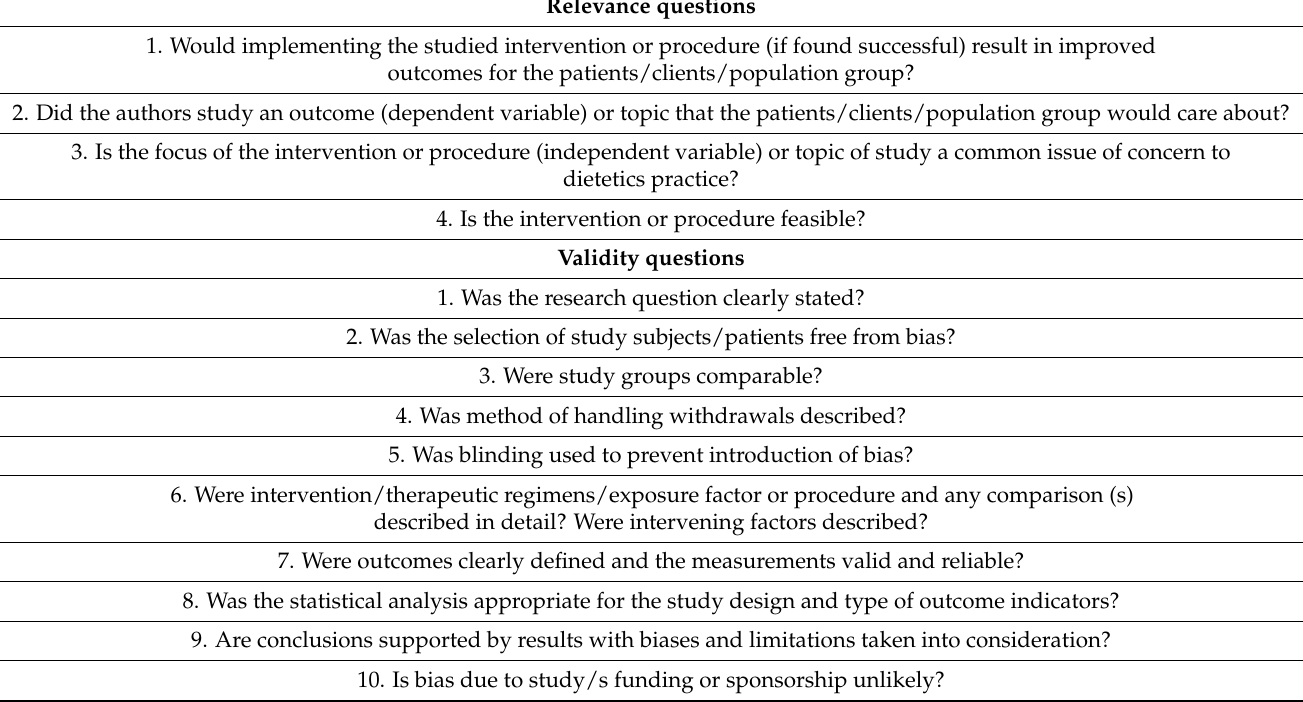
Table 2. Risk of bias